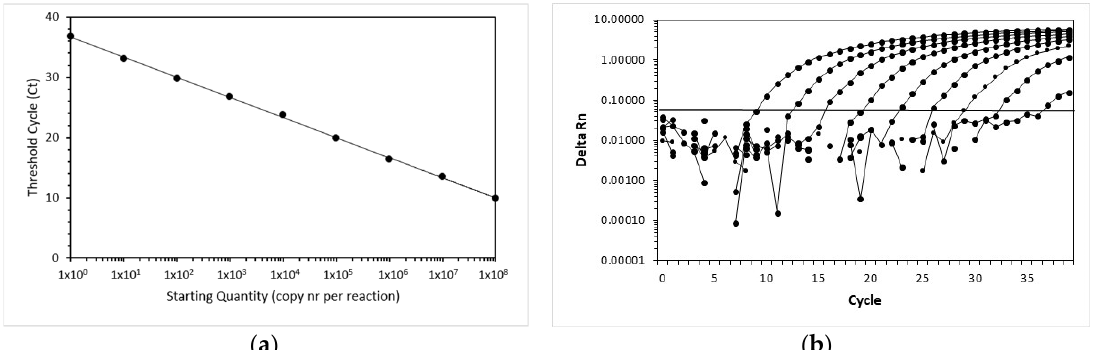
Figure 1. Linear range of amplification for the domestic cat gammaherpesvirus (FcaGHV1) real-time qPCR assay. ( a ) Amplification plots of a representative real-time qPCR assay show the cycle number versus the normalized reporter dye fluorescence. ( b ) The standard curve of a representative real-time qPCR assay shows the starting input quantity (copies per reaction) in a 10-fold serial dilution of standard template versus the measured threshold cycle. Rn is the fluorescence of the reporter dye divided by the fluorescence of a passive reference dye. DeltaRn is the normalized value of Rn obtained by subtracting the baseline value.